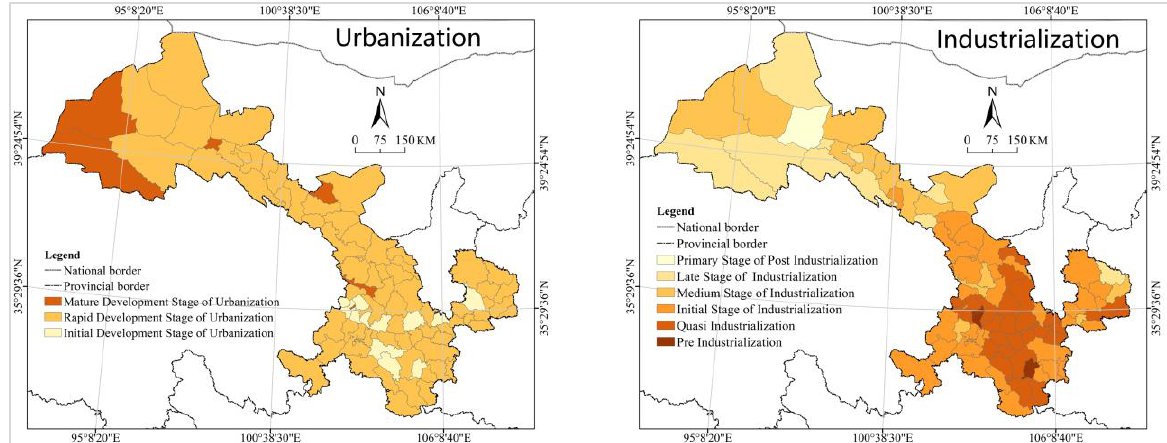
Figure 2. Analysis on the development stage of cities in Gansu province. Note: The thresholds for the classification of urbanization stages are 30% and 70%. In the industrialization stage, Chenery’s standard was adopted, and per capita GDP was used as the indicator. The conversion of 1970 and 2020 US dollars is calculated according to the GDP deflator, and the index value is 5.25. Pre-industrialization <735 $; quasi-industrialization <1470 $, initial stage of industrialization <2940 $, medium stage of industrialization <5880 $, late stage of industrialization, 11,025 $, primary stage of post industrialization <17,640 $.